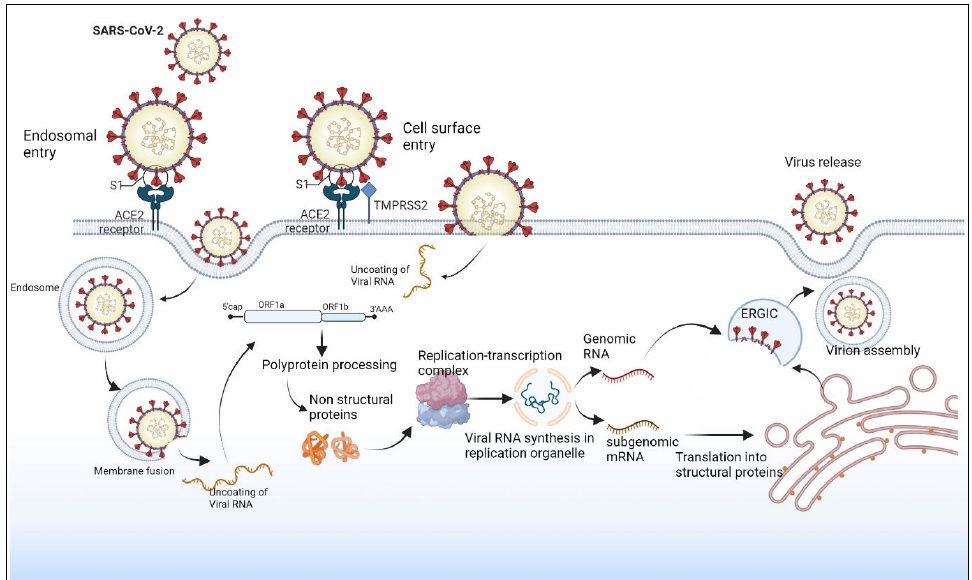
Figure 2. SARS-CoV-2 replication cycle. SARS-CoV-2 enters the cell via endosomal or cell surface entry. The virus attaches to the ACE2 receptor via the S1 subunit, and TMPRSS2 facilitates this process. The virus releases viral RNA into the cytoplasm and translates it into a polyprotein. Polyprotein later processes into structural and non-structural proteins. Virus assembles in ER-to-Golgi intermediate compartment (ERGIC) and releases via exocytosis. Created with BioRender.com.